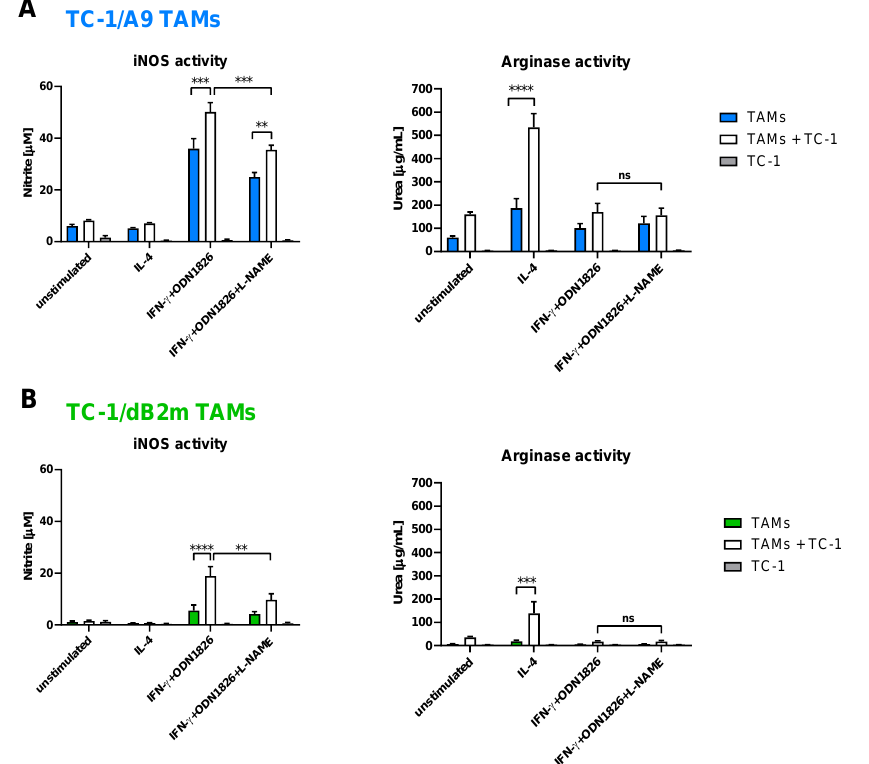
Figure 4. In Vitro modulation of arginine-metabolizing enzymes in co-cultures of TAMs with tumor cells. TAMs, TC-1 cells, and co-cultures of TAMs from TC-1/A9 ( A ) or TC-1/dB2m tumors ( B ) with TC-1 cells were stimulated with IL-4 or IFN-γ plus ODN1826 for 44 h. The activity of iNOS in M1 TAMs was blocked with L-NAME. Subsequently, supernatants from co-cultures were collected, and nitrite concentration and arginase enzymatic activity were measured with Griess reagent ( A , B ; left-hand graphs) and by microplate method on cell lysates ( A , B ; right-hand graphs), respectively. The unstimulated cells were used as a negative control. Columns indicate mean of three independent experiments; bars: ± SEM; ns; non-significant, ** p < 0.01, *** p < 0.001, **** p < 0.0001.